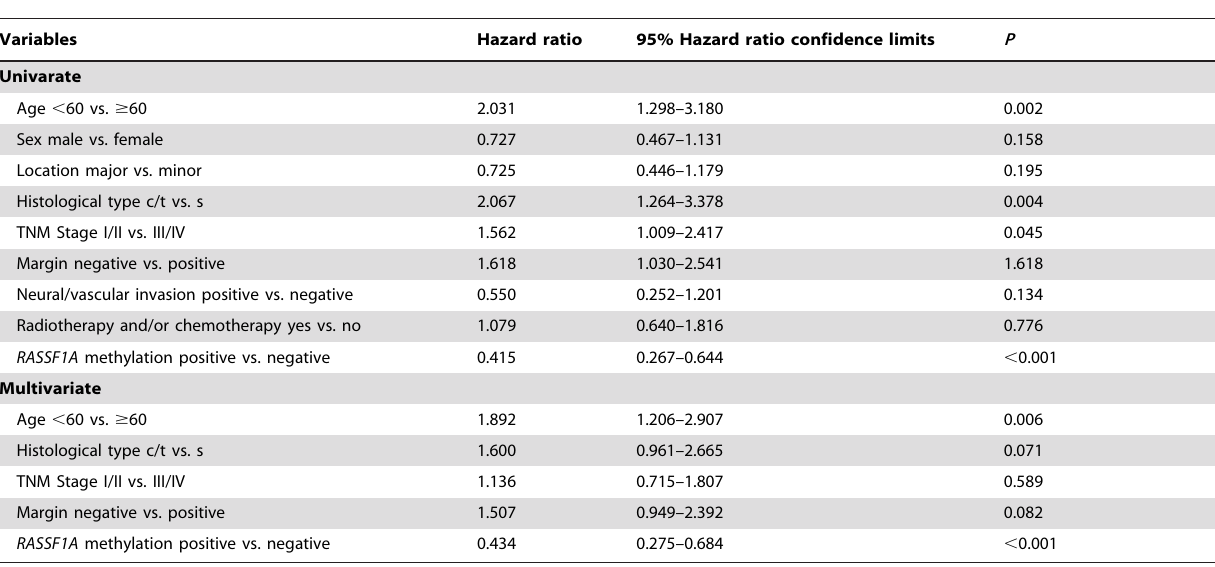
Table 3. Summary of Cox model estimates for disease-free survival in 167 patients with